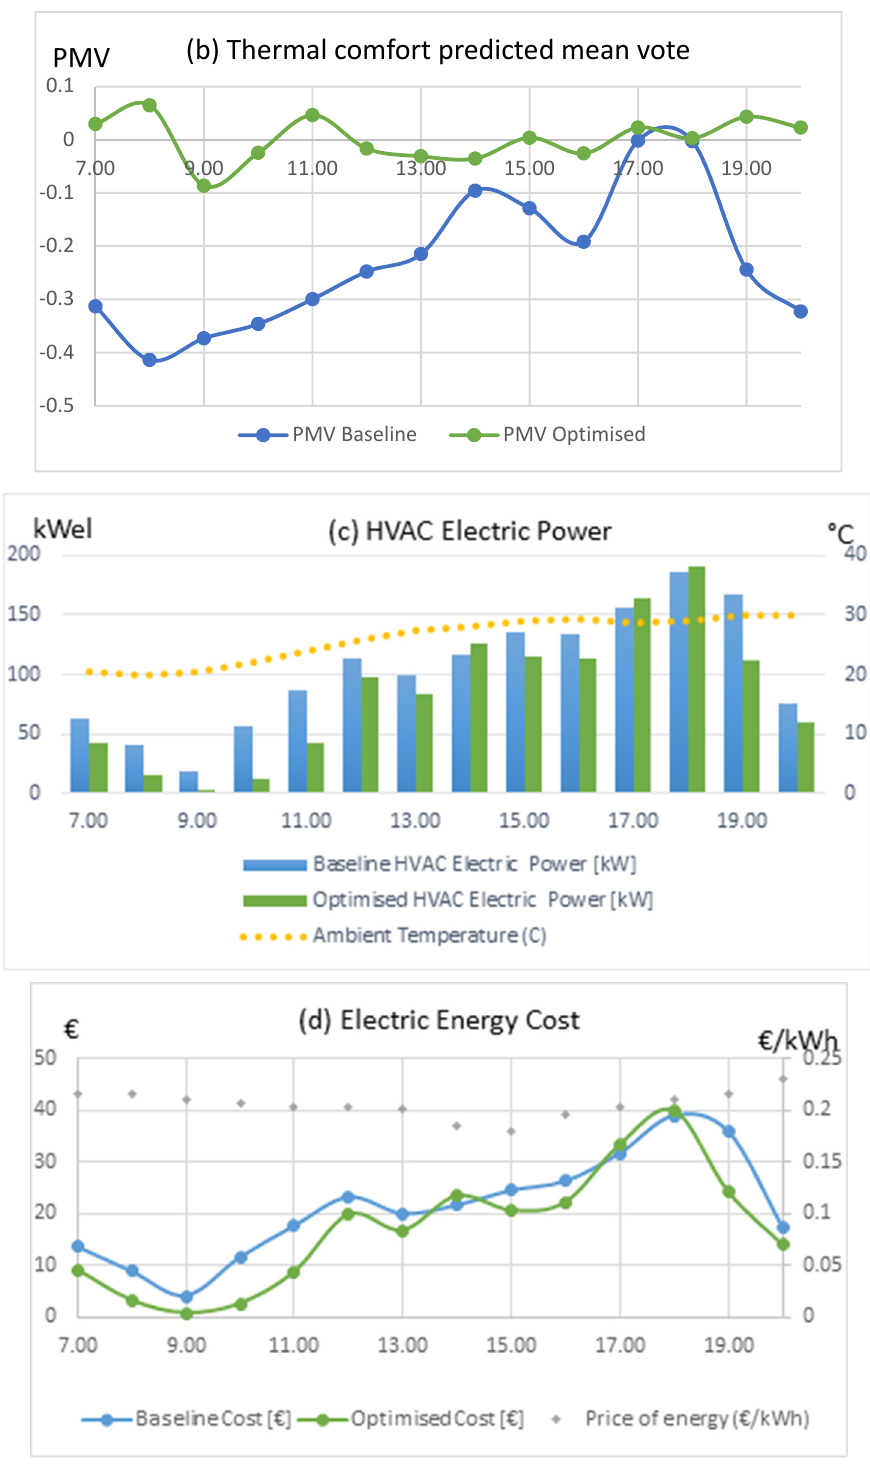
Figure 5. GA HVAC optimization results for 15 August 2018 (summer).